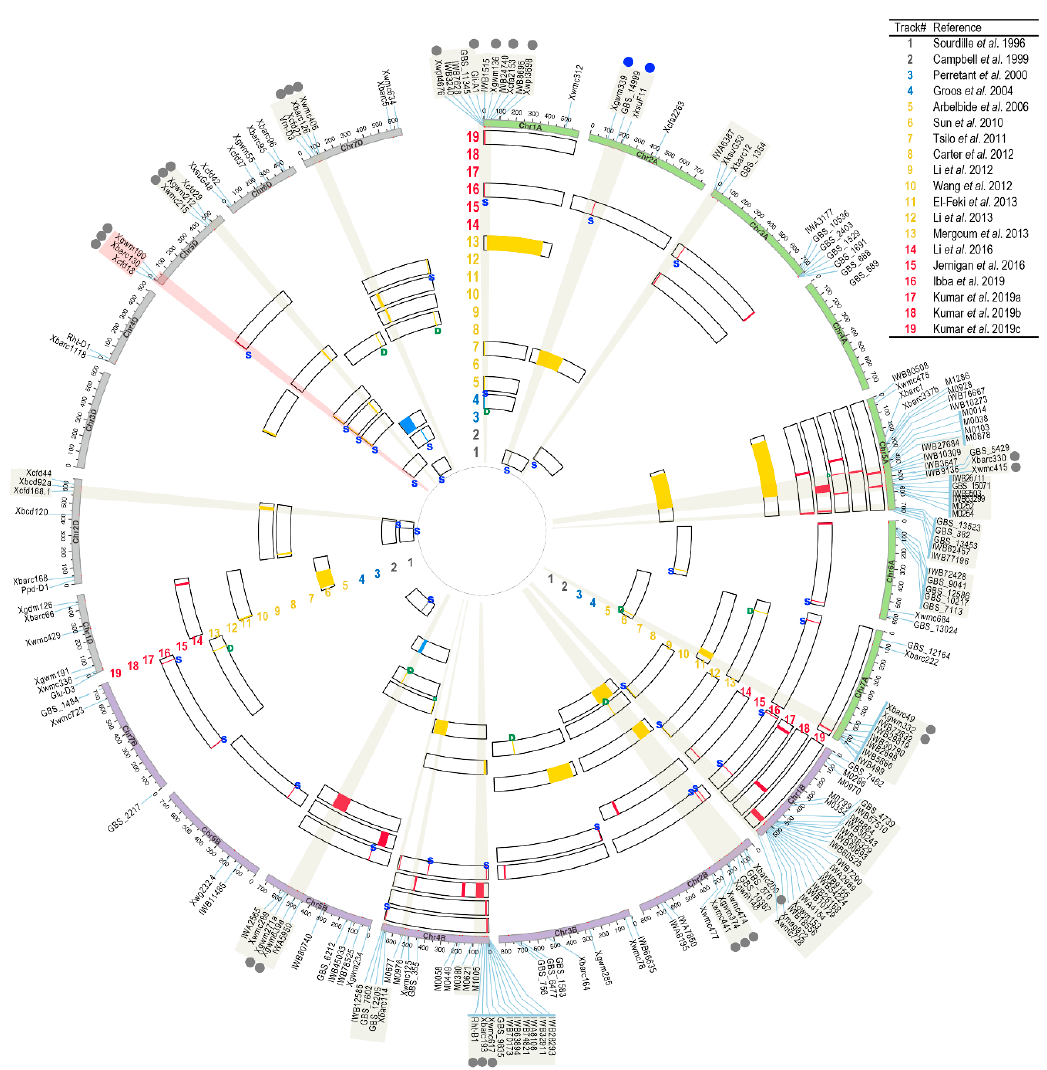
Figure 1. Projection of the QTL regions and genetic markers associated with wheat kernel hardness on the reference genome of common wheat Chinese Spring (CS42, RefSeq v1.0) [2]. The QTL regions associated with kernel hardness were retrieved from nineteen QTL mapping studies reviewed in this article [36,37,98–118]. Detailed information about these QTL-mapping studies and their projected QTLs or markers are provided in Table 1 and Supplementary Table S1. The left and right boundaries of a QTL are defined by two genetic markers according to the corresponding study. In some cases, only the left or right marker can be accurately located on the reference genome of CS42, leaving only one kernel hardness-associated marker projected onto the map. If both the left and right boundary markers can be located on the genome, the QTL region is indicated using a green letter “D” (meaning “double markers”). If only the left or right boundary marker can be located on the genome, the QTL / single marker is indicated using a blue letter “S” (meaning “single marker”). The out-most track denotes the wheat genome assembly. The A, B and D genomes are colored in green, purple and gray, respectively. The outer to inner tracks represent the 19 QTL-mapping studies, labeled using the first author and year of publication. For each study (track), only the chromosome on which a kernel hardness-associated QTL region could be located is shown, with the QTL regions or markers highlighted in colors (i.e., gray, blue, yellow and red). The colors used to highlight the QTL regions, i.e., gray, blue, yellow and red, denote the main types of markers used in each QTL mapping study, namely, RFLP, RFLP + SSR, SSR + DArT and SNP, respectively (Table S1). All of the markers used for QTL projection are labeled outside the wheat genome track.